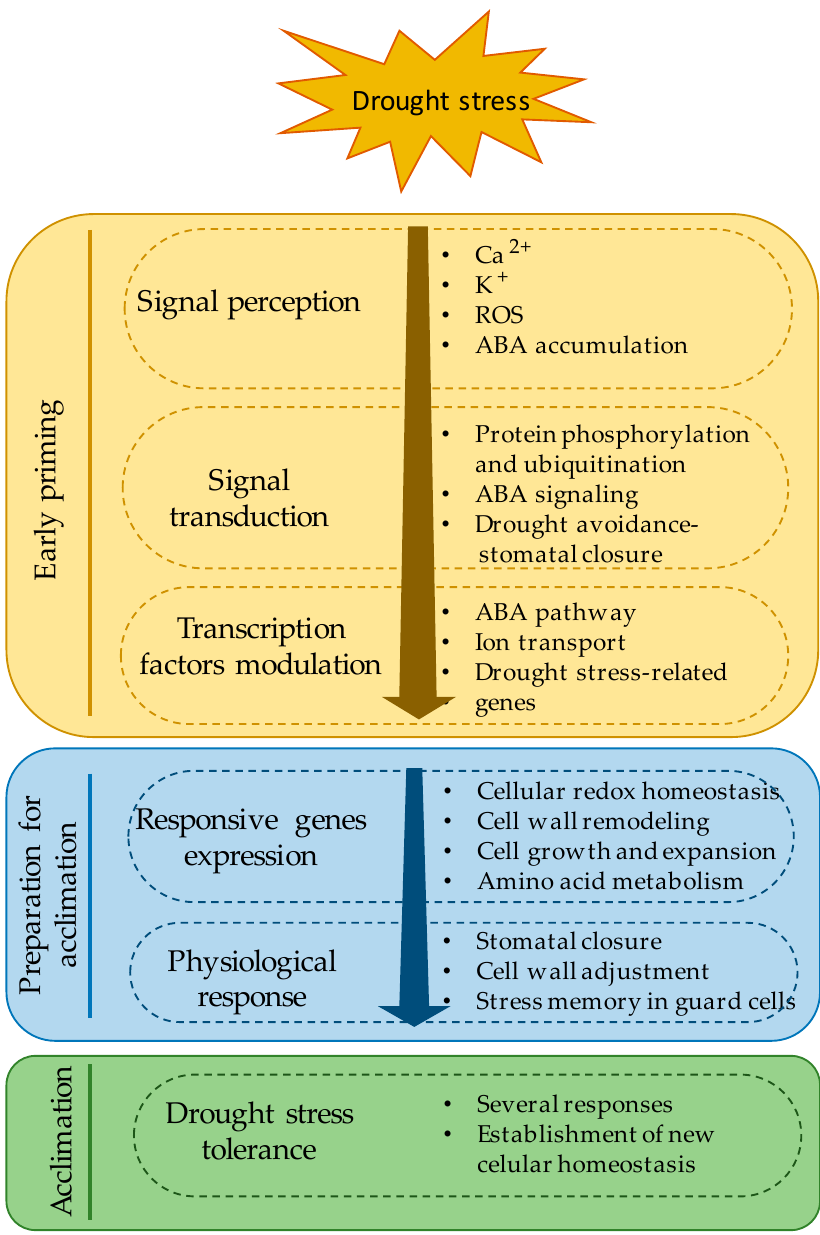
Figure 2. General description of physiological responses of plants to drought stress conditions. ROS: reactive oxygen species and ABA: abscisic acid.